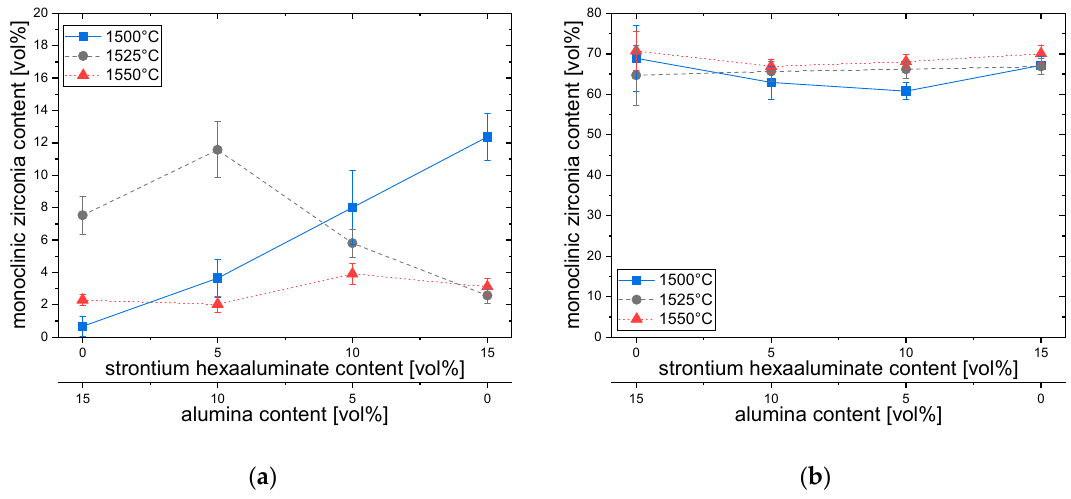
Figure 5. Monoclinic phase content of zirconia depending on composition and sintering temperature, measured on: ( a ) Polished surfaces; ( b ) Fracture surfaces.